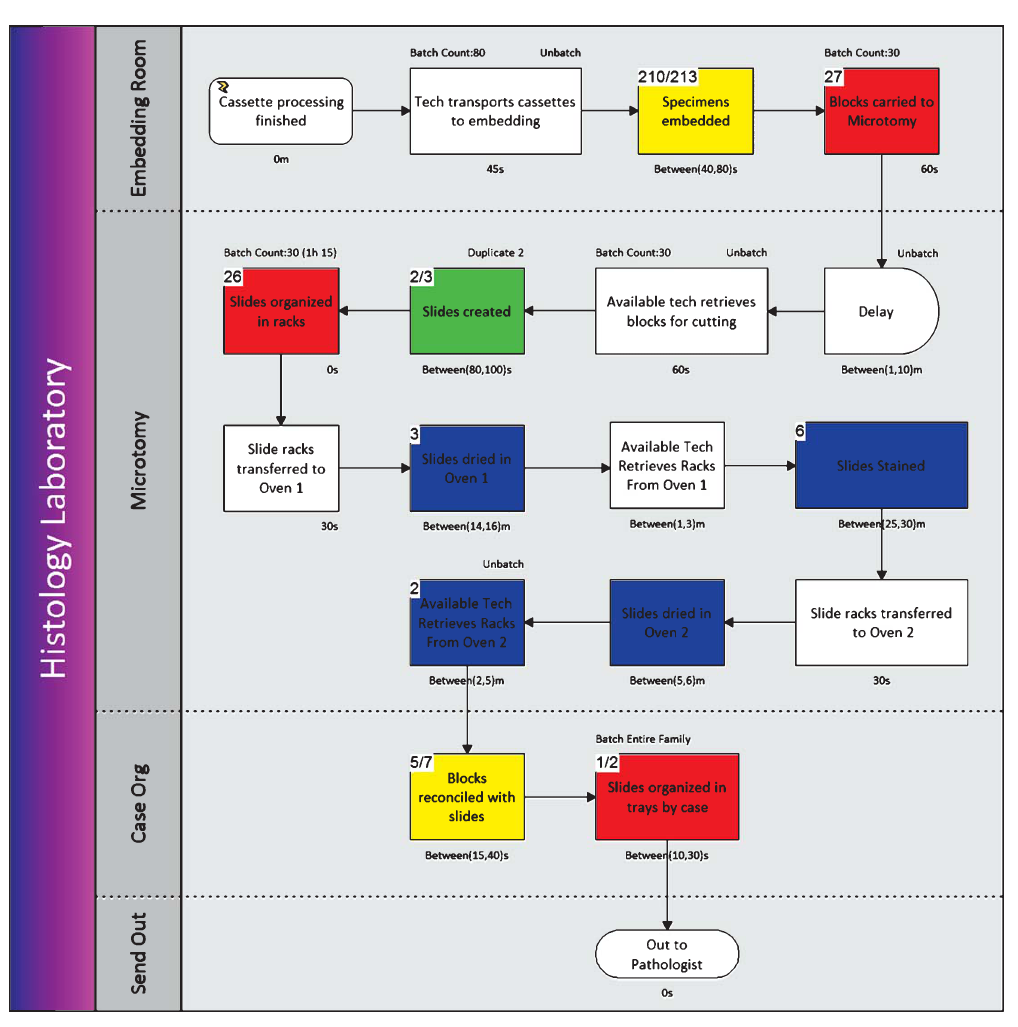
Fig. 3. Running simulations in iGrafx ® 2011 (trace mode) with the following color representations: Green, transactions (blocks or slides) moving through the process; Blue, work being done on a transaction or group of transactions; Red, task blocked until task rules are met (batch or join activity), Yellow, transaction is waiting for a resource and cannot continue until one is free; White, activity inactive (no